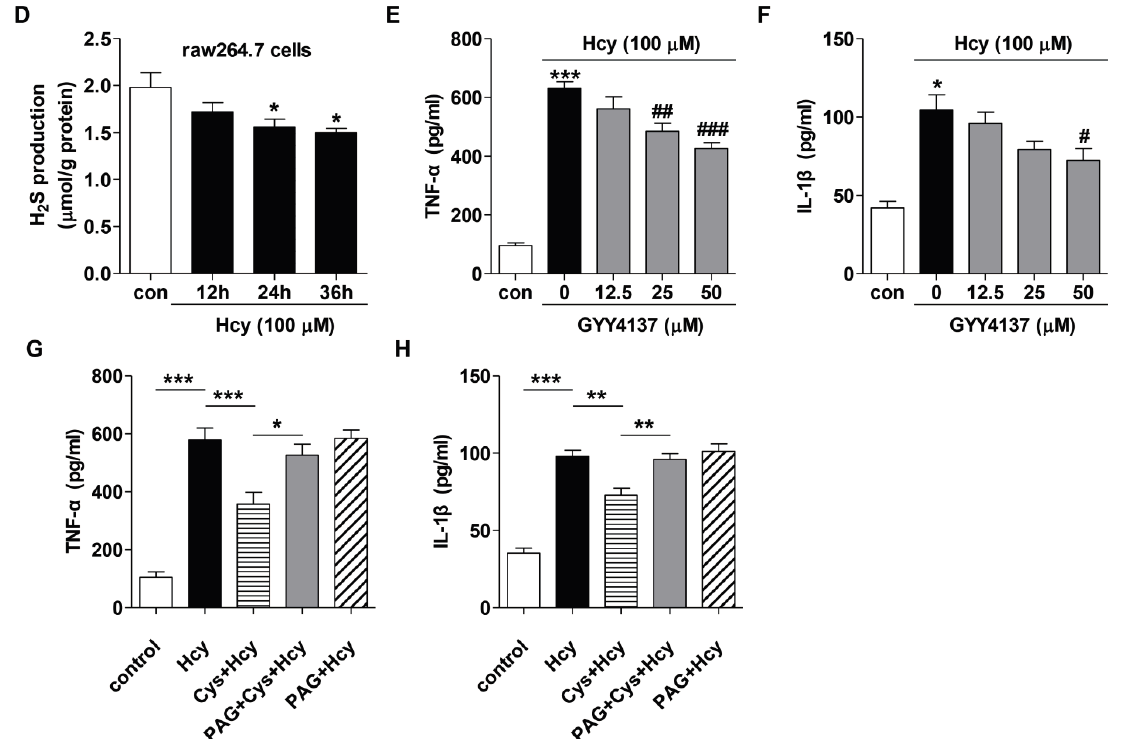
Figure 2. Effect of H 2 S modulation on the pro-inflammatory cytokines in the plasma of methionine-treated mice and Hcy-treated raw264.7 cells. ( A – C ) H 2 S-releasing agent GYY4137 ameliorated while CSE inhibitor PAG aggravated the increases of plasma TNF- α ( A ) and IL-1 β ( B ) levels in methionine diet-treated mice. Neither GYY4137 nor PAG altered the plasma Hcy level ( C ); For methionine diet, C57BL/6 mice were administered with 2% methionine in drinking water for 14 consecutive days. For GYY4137 and PAG treatment, mice were pre-treated with GYY4137 (50 mg/kg/day, i.p.) or PAG (37.5 mg/kg/day, i.p.) for three days before subjected to 2% methionine supplement. n = 4–7 animals in each group; ( D ) Hcy treatment reduced H 2 S production in raw264.7 macrophages; ( E , F ) GYY4137 (12.5, 25, 50 µM) pre-treatment for 1 h attenuated the increases of TNF- α and IL-1 β in Hcy (100 µM, 24 h)-treated macrophages; ( G , H ) Raw264.7 cells were pre-treated with Cys (1 mM), in the presence or absence of PAG (1 mM) co-treatment for 30 min, before being subjected to Hcy (100 µM, 24 h) treatment. n = 4–9. * p < 0.05, ** p < 0.01, *** p < 0.001 compared to its corresponding control group. # p < 0.05, ## p < 0.01, ### p < 0.001 compared to Hcy group. N.S., not